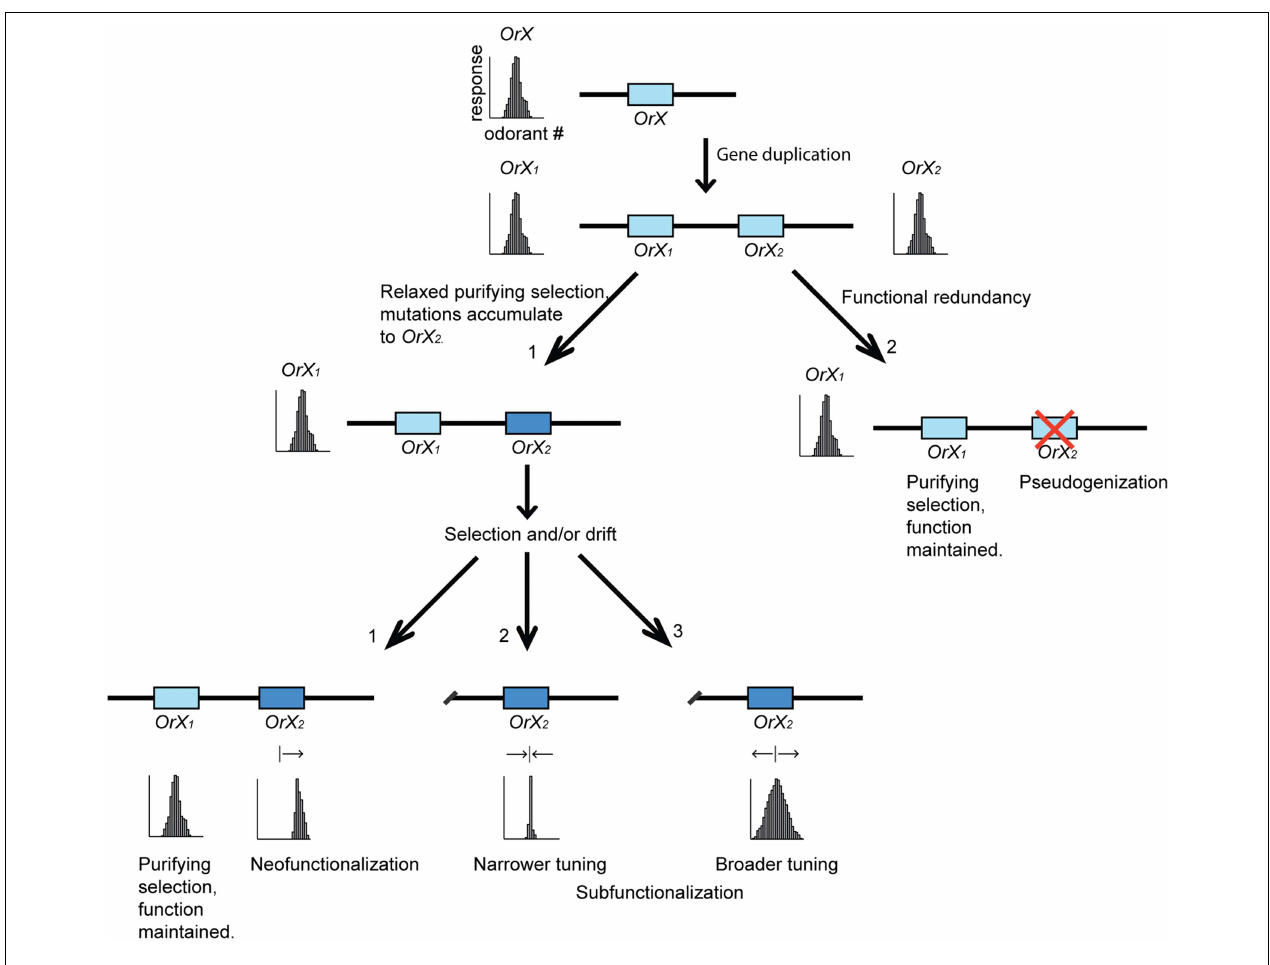
other receptor remains intact. The mutated OR might acquire a novel function (neofunctionalization), or a similar function as its paralog (subfunctionalization). The tuning width can evolve by natural selection or genetic drift to become narrower or broader as compared to the parental receptor ( OrX ). The tuning curves represent crude examples of different tuning widths and, as such, do not imply full coverage of chemical